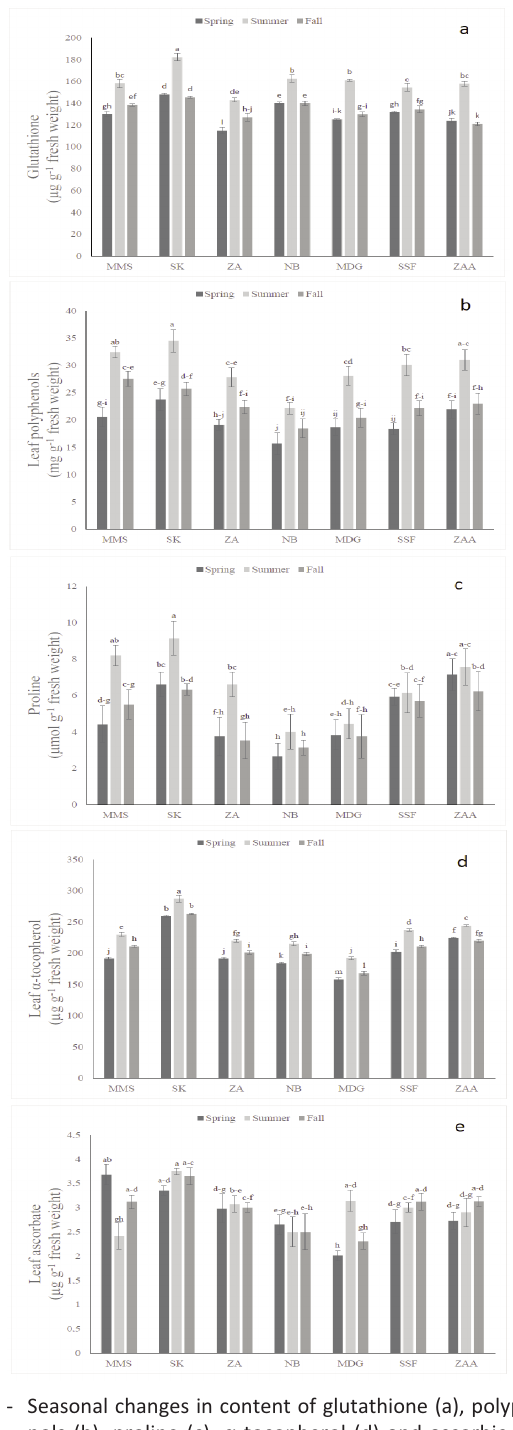
Fig. 2 ­ Seasonal changes in content of glutathione (a), polyphe­ nols (b), proline (c), α­tocopherol (d) and ascorbic acid (e) in studied cultivars. Columns with different letters represent significant differences at 5% probability using Duncan’s multiple range test, those are valid for all columns.